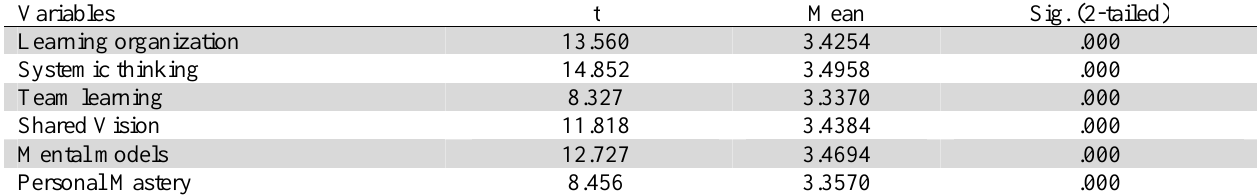
One-Sample Test on learning organization